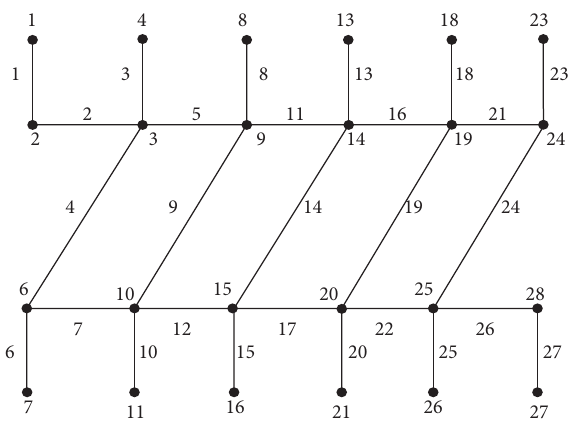
Figure 13: A classical mean labeling of SL